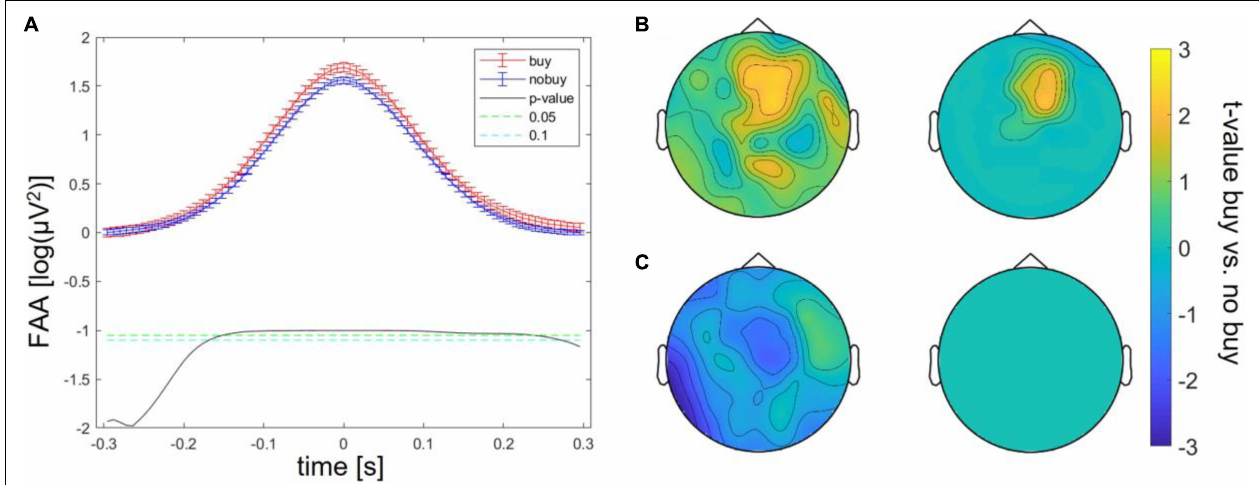
FIGURE 3 | Differences between buying and no-buying trials in Study 1 with all batches combined, (A) increased frontal alpha at FAA peaks, (B) increased frontal theta at theta peaks (left: raw, right: masked by cluster corrected p -level < 0.05), (C) decreased occipital alpha at FAA peaks (left: all values, right: masked by cluster-corrected p -level < 0.05).